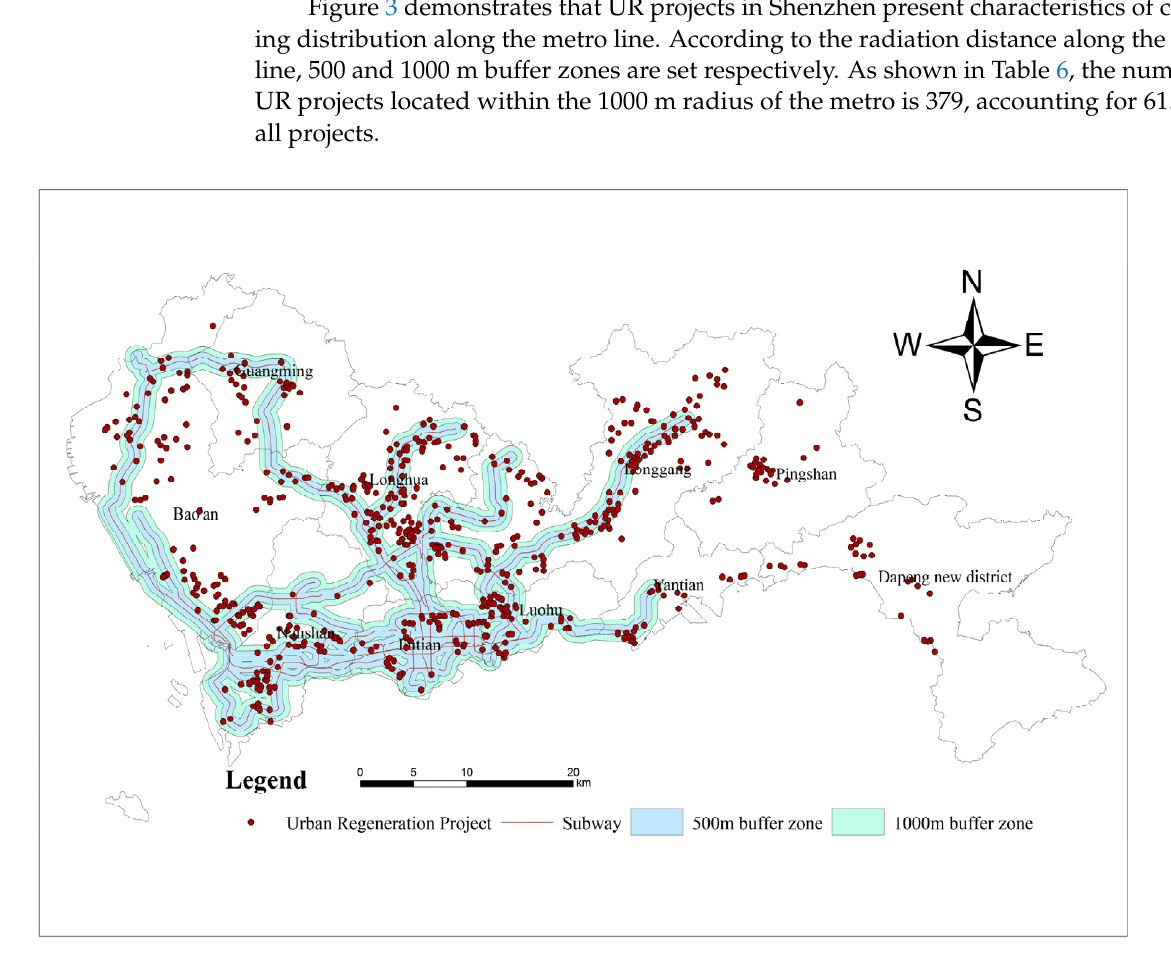
Figure 3. Distribution of UR along the metro. Table 6. Number of UR projects in the metro buffer zone.